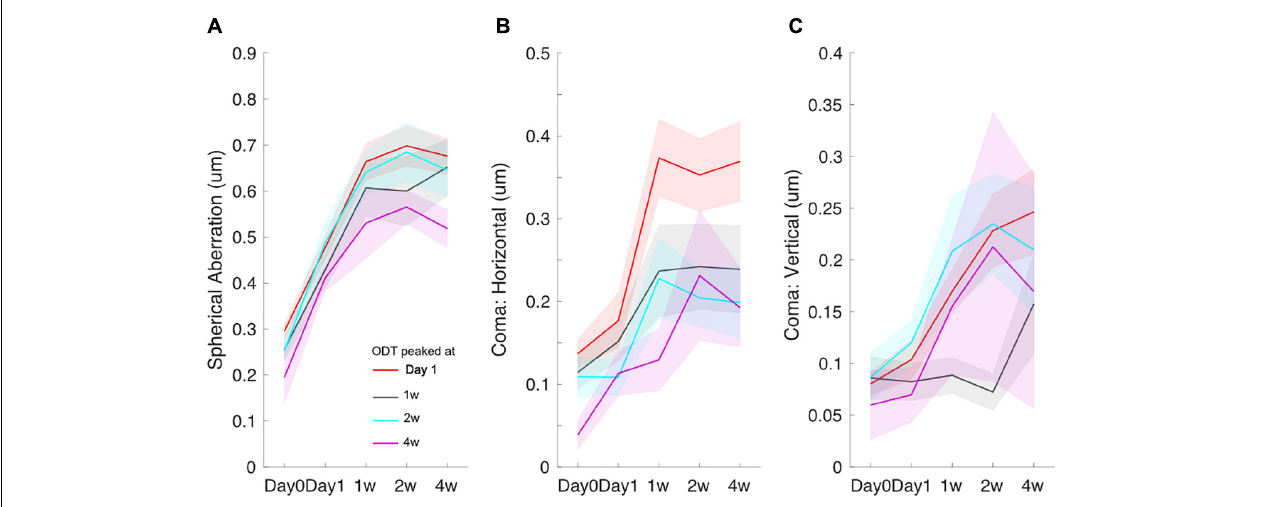
FIGURE 4 | Time courses of spherical aberration (A) , horizontal coma (B) , and vertical coma (C) . Redline: subjects whose ODT peaked at day 1, black line: subjects whose ODT peaked at 1 week, blue line: subjects whose ODT peaked at 2 weeks, and purple line: subjects whose ODT peaked at 4 weeks. The shaded area indicates mean ± one standard